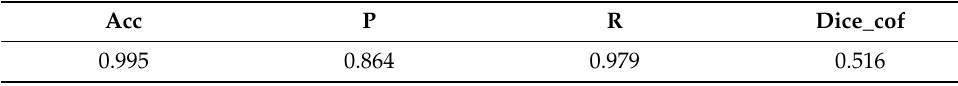
( b ) Figure 7. The visual results of the first model for cancer detection on LiTS dataset: ( a ) normal case (no tumor detection); ( b ) abnormal case (tumor detection).